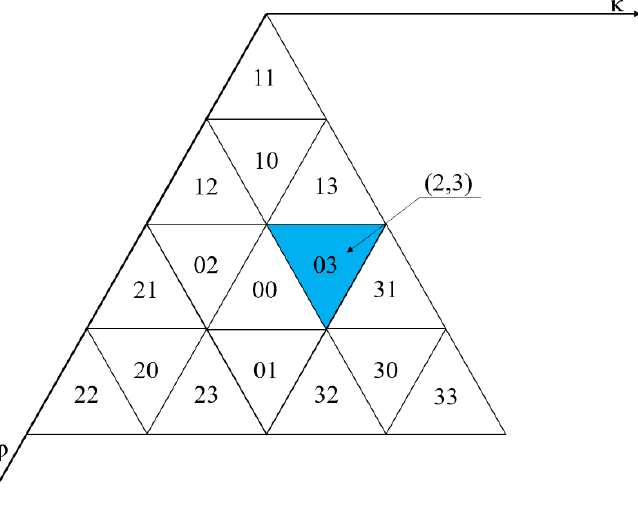
Figure 14. Schematic diagram of row–column encoding.